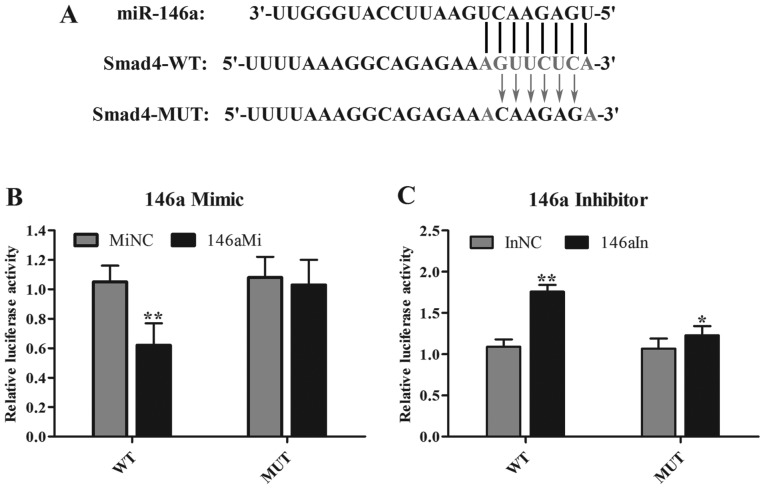
Smad4 is a direct target of miR-146a. (A) Schematic representation of the sequence alignment of the wild-type Smad4 3′-UTR (light color) indicating the binding site of the miR-146a and the mutant Smad4 3′-UTR for pMIR-report (WT, wild-type; MUT, mutant). (B) Compared with negative control group (MiNC), miR-146a mimics (146aMi) significantly inhibited the reporter luciferase activity of the wild-type Smad4 3′-UTR (**P<0.01; bars, means ± SD; n=3) but not that of the mutant Smad4 3′-UTR (P>0.05; bars, means ± SD; n=3). (C) Compared with inhibitor negative control group (InNC), the reporter luciferase activity of the wild-type Smad4 3′-UTR was significantly increased by miR-146a inhibitor (146aIn) (**P<0.01; bars, means ± SD; n=3) than that of the mutant Smad4 3′-UTR (*P<0.05; bars, means ± SD; n=3).